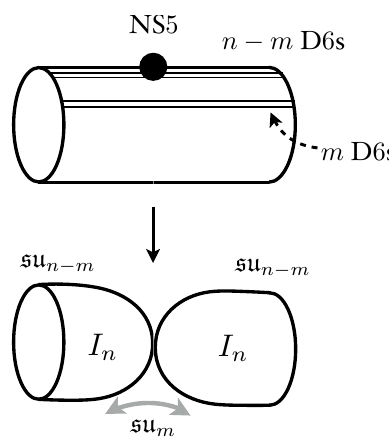
Figure 4 . On the IIA side, we can move m of the D6s o(cid:11) the NS5s and make them recombine. On the IIB side, this corresponds to a gauge algebra su m that is shared between two curves meeting at a point. We denote this with a double-sided